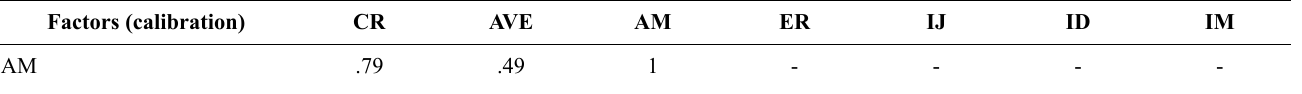
Table 3 Internal reliability, convergent and discriminant validity and average variance extracted – Calibration and Validation samples Factors